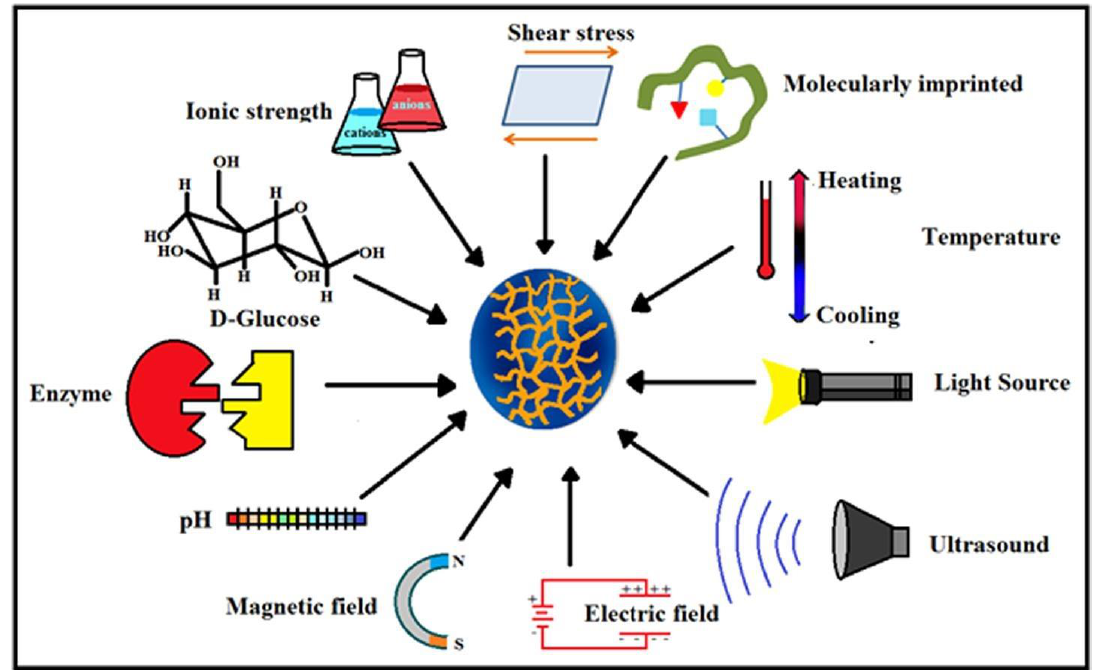
Figure 17. Environmental stimuli sensitive to hydrogels [163] .